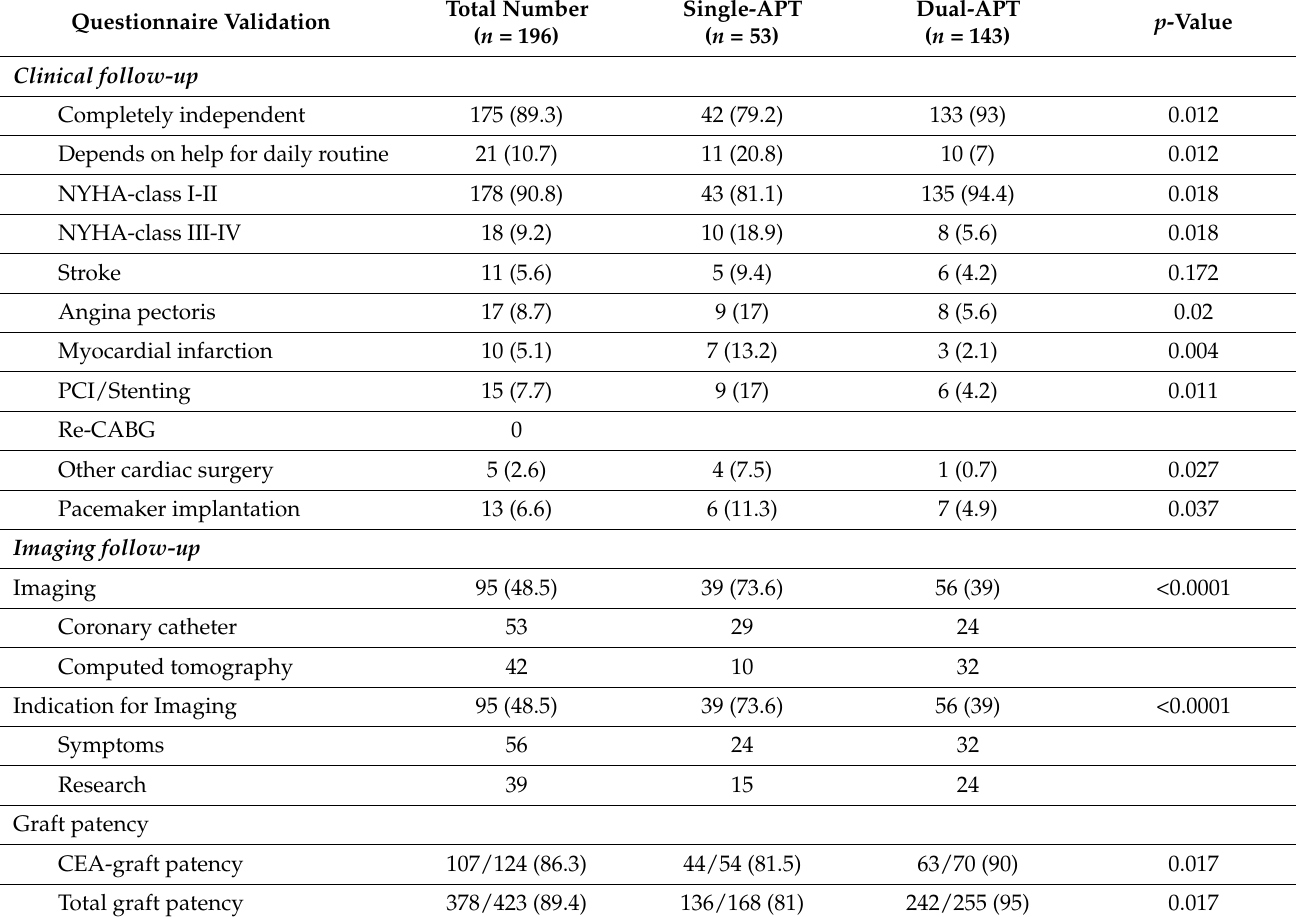
Table 5. Clinical and imaging